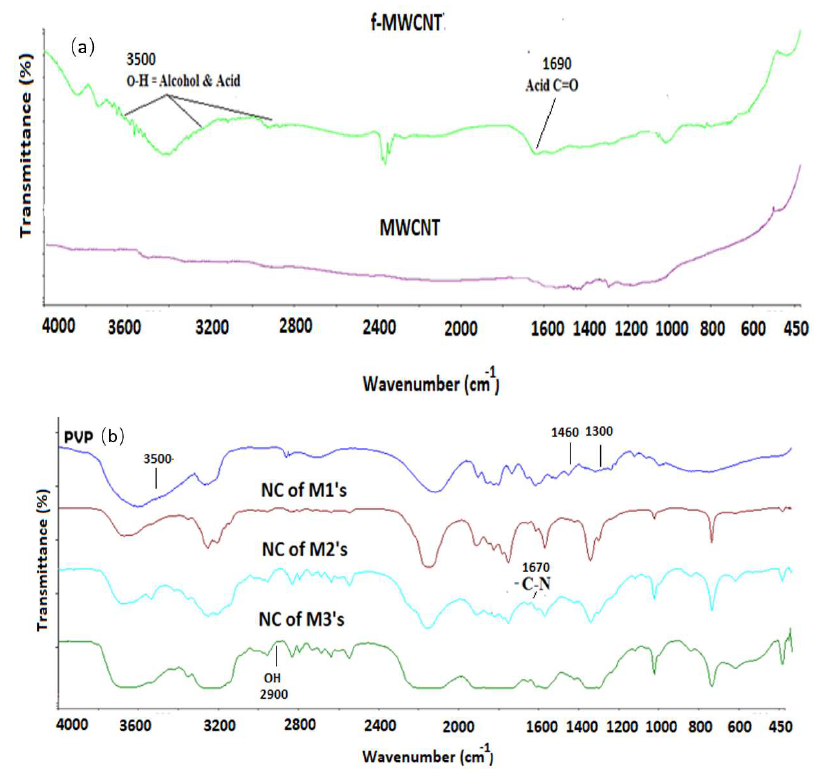
Figure 2. The XRD results of f-MWCNT and MWCNT.